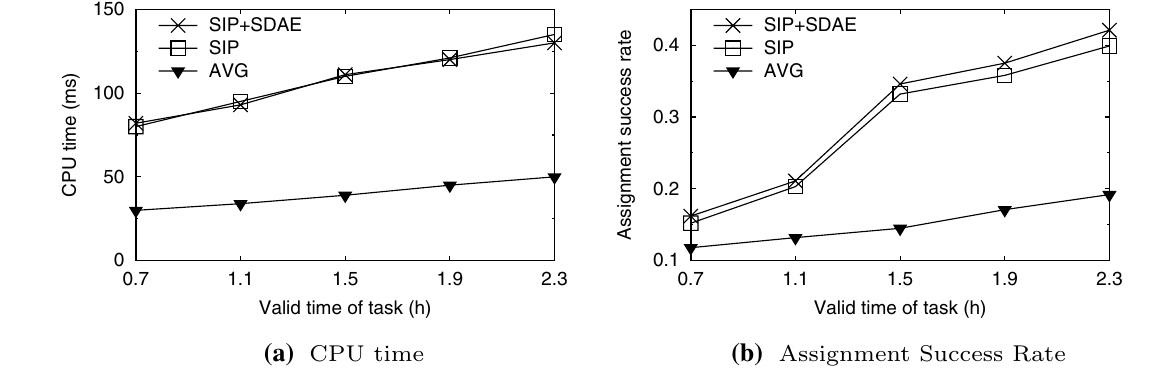
Fig. 3 Performance of preference modeling: effect of e − p